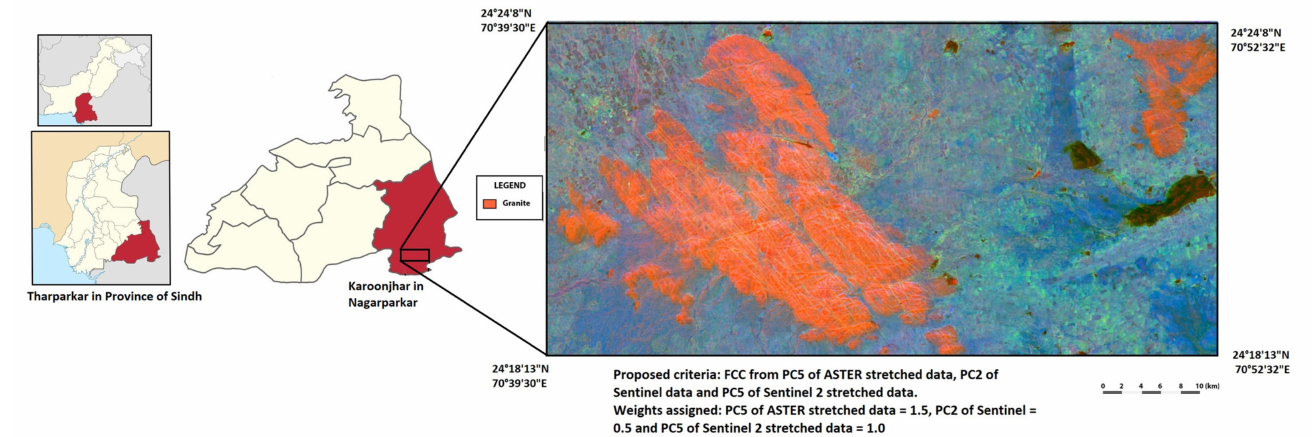
Figure 15. Granite mapping in Karoonjhar Mountains in Nagarparkar with one component of the raw and stretched Sentinel-2 datasets and the stretched ASTER dataset